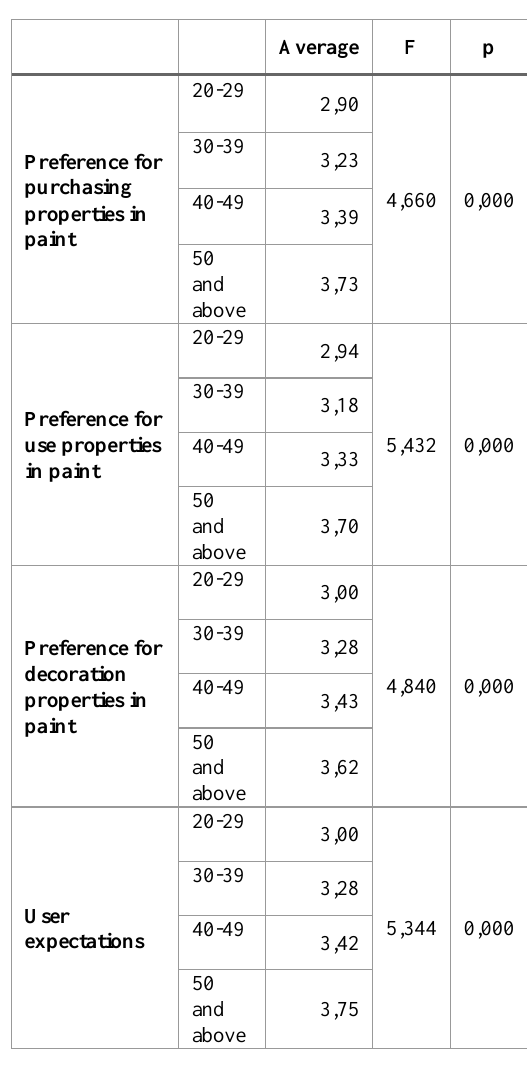
Table 16: ANOVA Test on Consumers' Preferences for Paint by